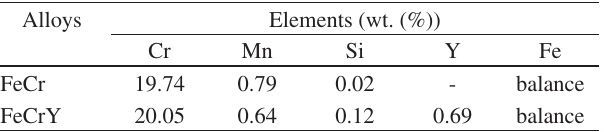
Table 1. Chemical composition of the alloys, as determined by X ray fluo- rescence spectroscopy. Alloys